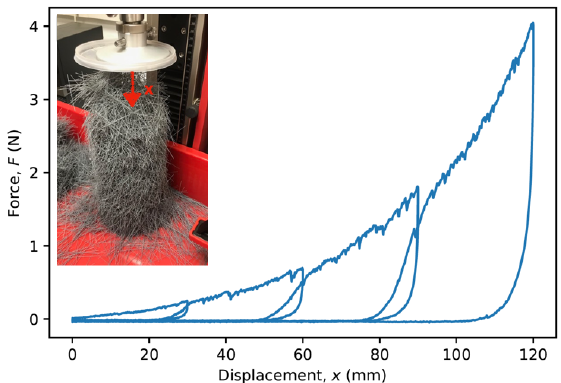
Figure 3. Typical force-displacement curve of axial compression cycles of a tower of